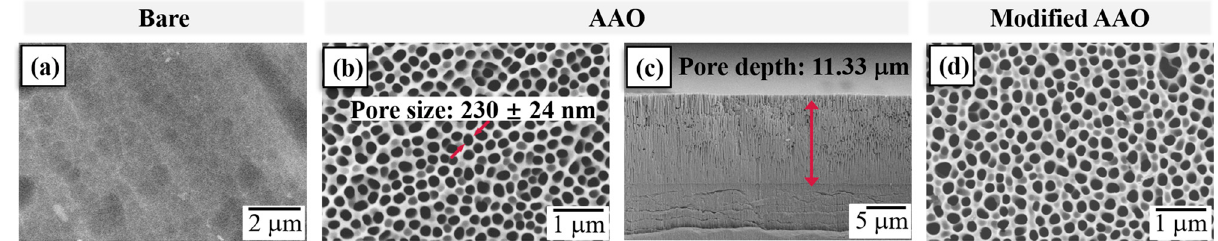
Figure 1. Surface micrographs of ( a ) bare, ( b ) unmodified AAO and ( d ) modified AAO. ( c ) Cross- sectional micrograph of unmodified AAO.